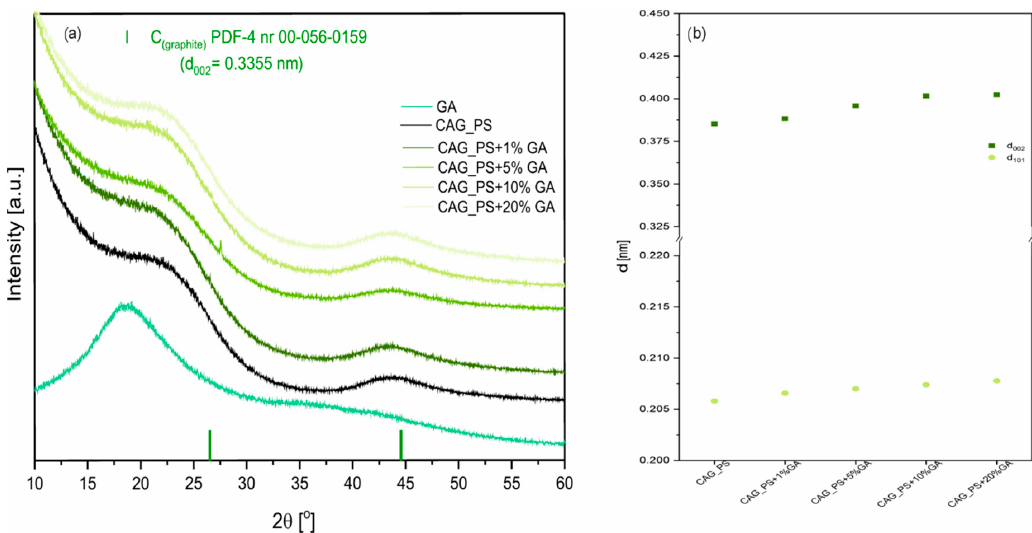
Figure 1. ( a ) X-ray powder diffraction patterns of modified carbon aerogel materials (CAG_PS) with gum arabic (GA) and ( b ) the interplanar spacing values for the obtained samples.